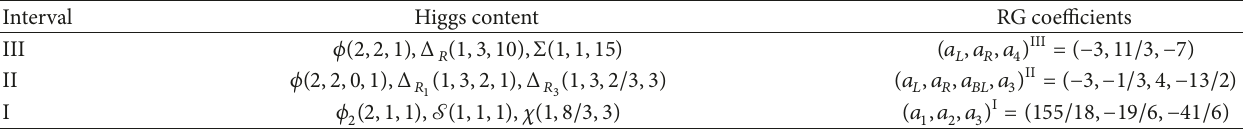
Table 1: The Higgs content and the RG coefficients in the energy intervals for our